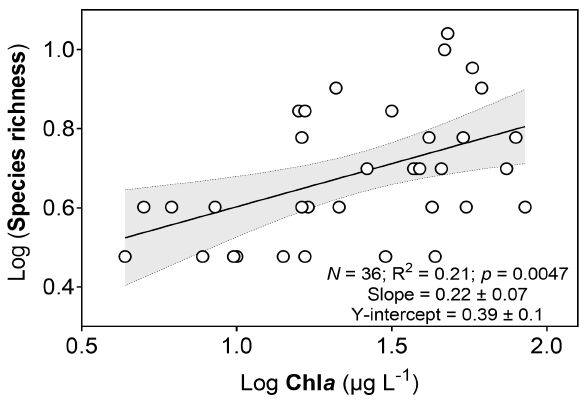
Figure 3. Relationships between richness of the fish species caught and Chl a . The dashed line represents the 95% confidence band. N , number of lakes; Chl a , chlorophyll a concentration in phytoplankton.